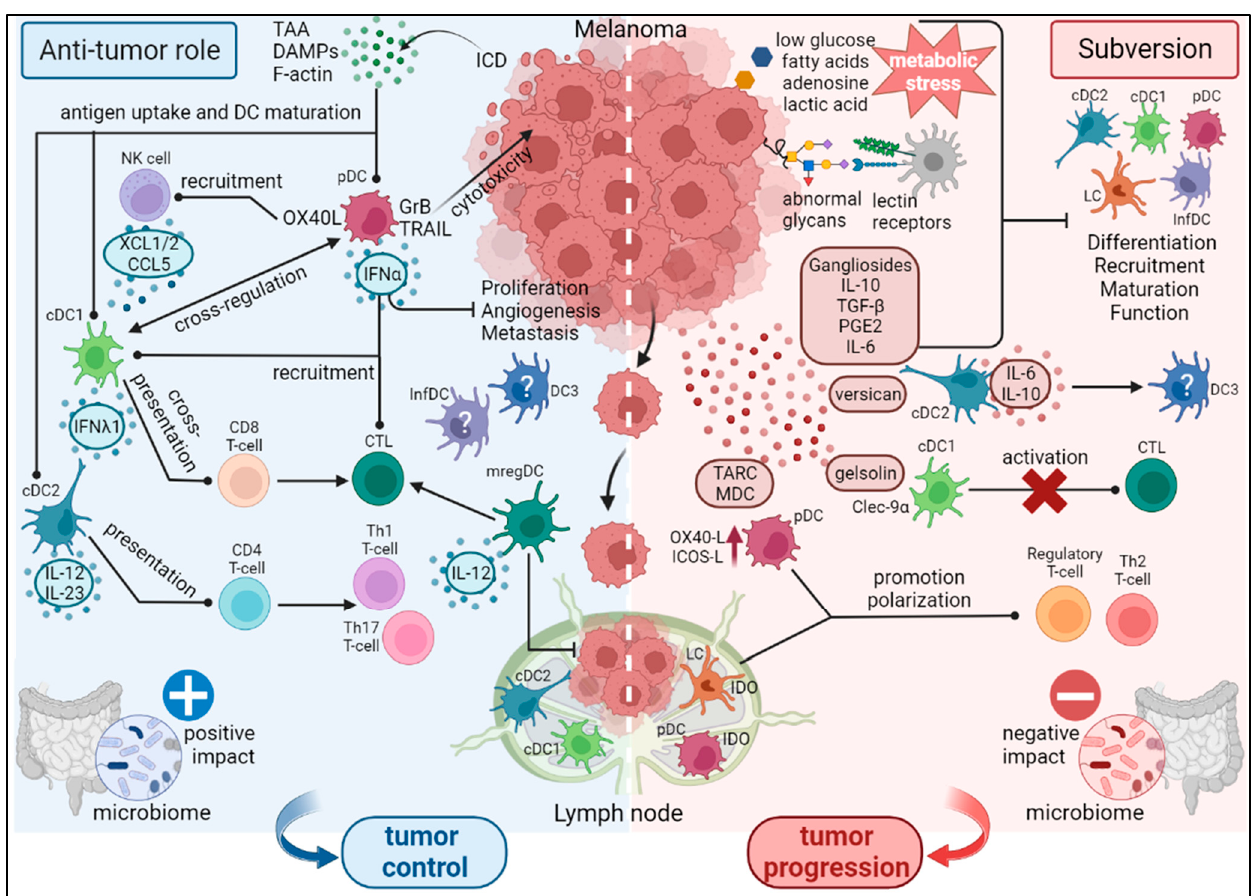
Figure 1. Dual role of DC subsets during melanoma development. DCs are central regulators of anti-melanoma immune responses and subsequent outcome. DCs display a puzzling role in the control of tumor development as they harbor both anti-tumor and pro-tumor functions. On one hand (left part), DCs are active players in orchestrating robust anti-tumor immunity by triggering cytotoxic CD8+ T cells through TAA cross-presentation, recruiting and activating NK cells, ending up in tumor control. On the other hand (right part), melanoma tumor cells exploit DC versatility to subvert their functions. Many factors secreted by melanoma tumor cells interfere with DC differentiation, maturation and function, leading to immunosuppressive / tolerogenic DCs and driving regulatory and Th2 responses. Abnormal glycans, unfavorable metabolic environment and specific microbiome can also negatively impact DC subsets. All these pathways favor tumor progression. This figure illustrates both the intra-tumoral heterogeneity of the DC subsets encountered in melanoma, the potential crosstalk between these DC subsets, and the prognostic value of DC subsets in melanoma.